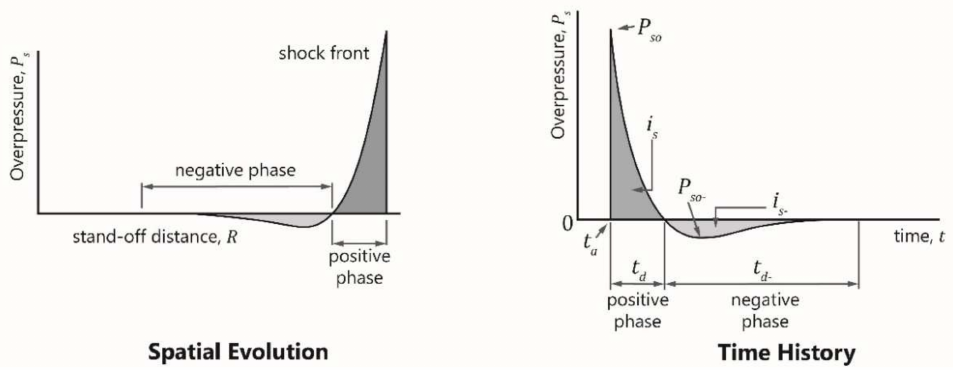
Figure 1. Time-history and spatial evolution of a blast adapted from